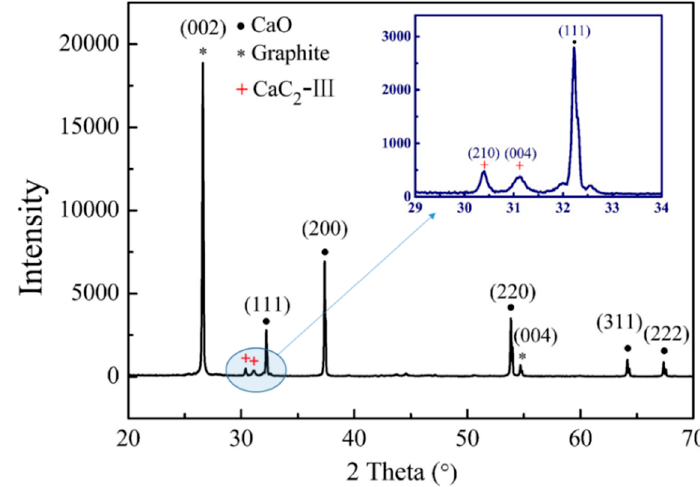
Figure 9. XRD pattern of MW heated product at 1570 °C.